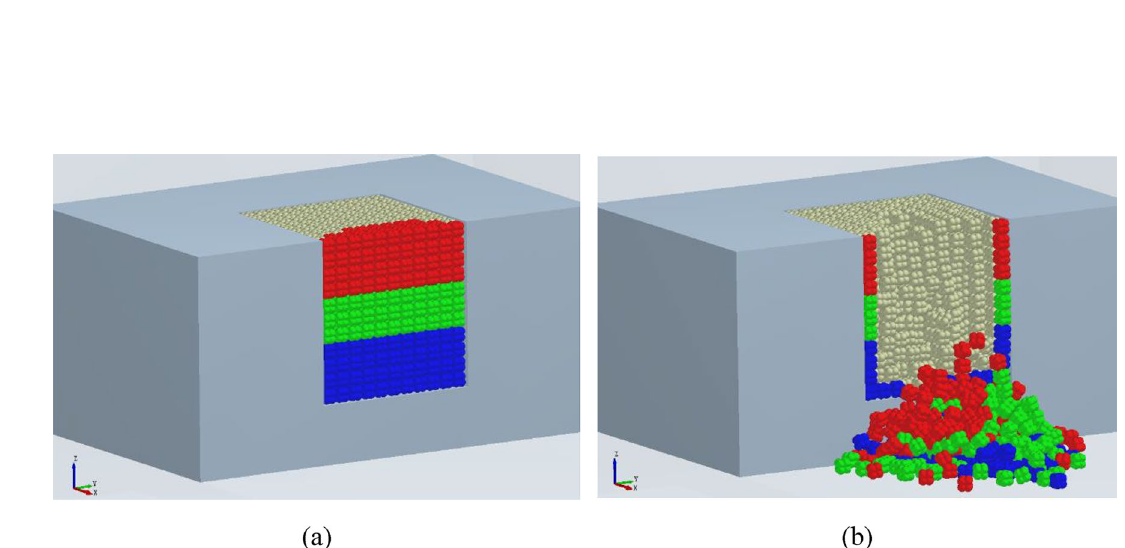
Figure 17. Layered accumulation of blocks (0.6